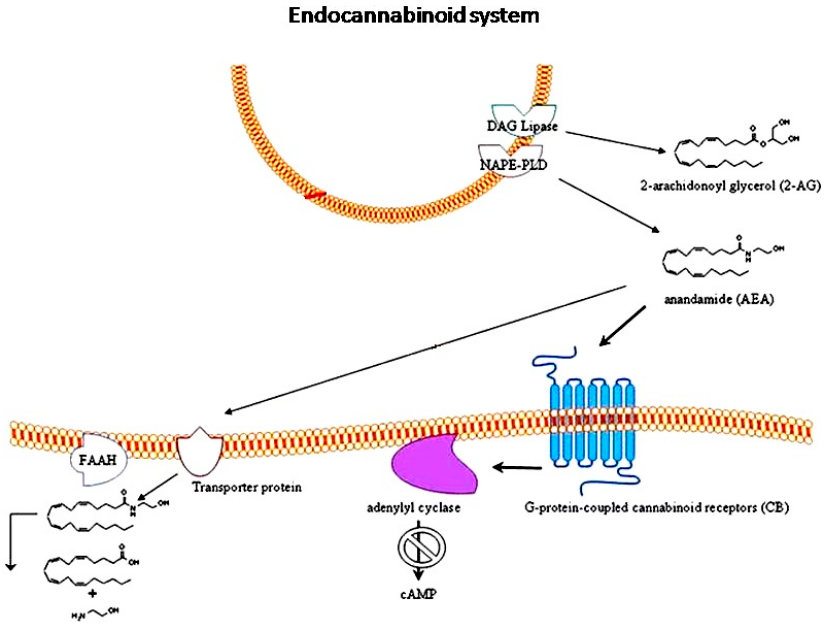
Figure 1. Endocannabinoids, such as N -arachidonoylethanolamine (anandamide, AEA)